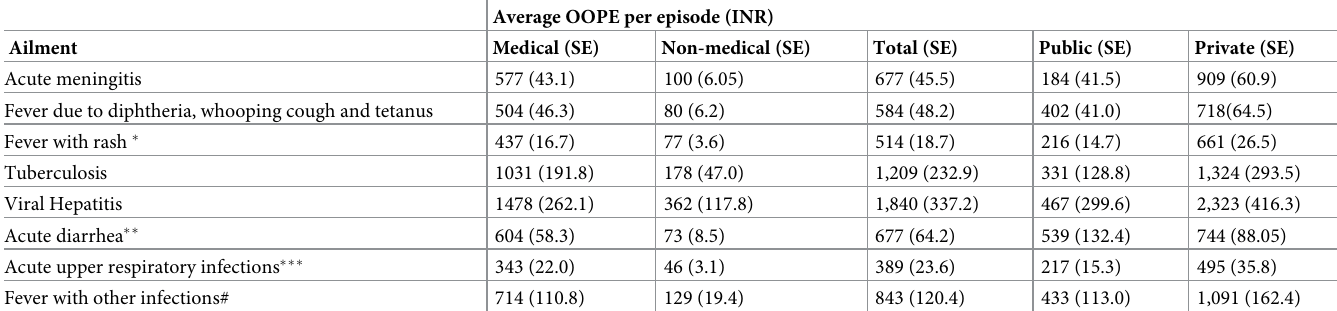
Table 2. Per episode OOPE (INR) on outpatient care for childhood infections in India, 2018. Average OOPE per episode